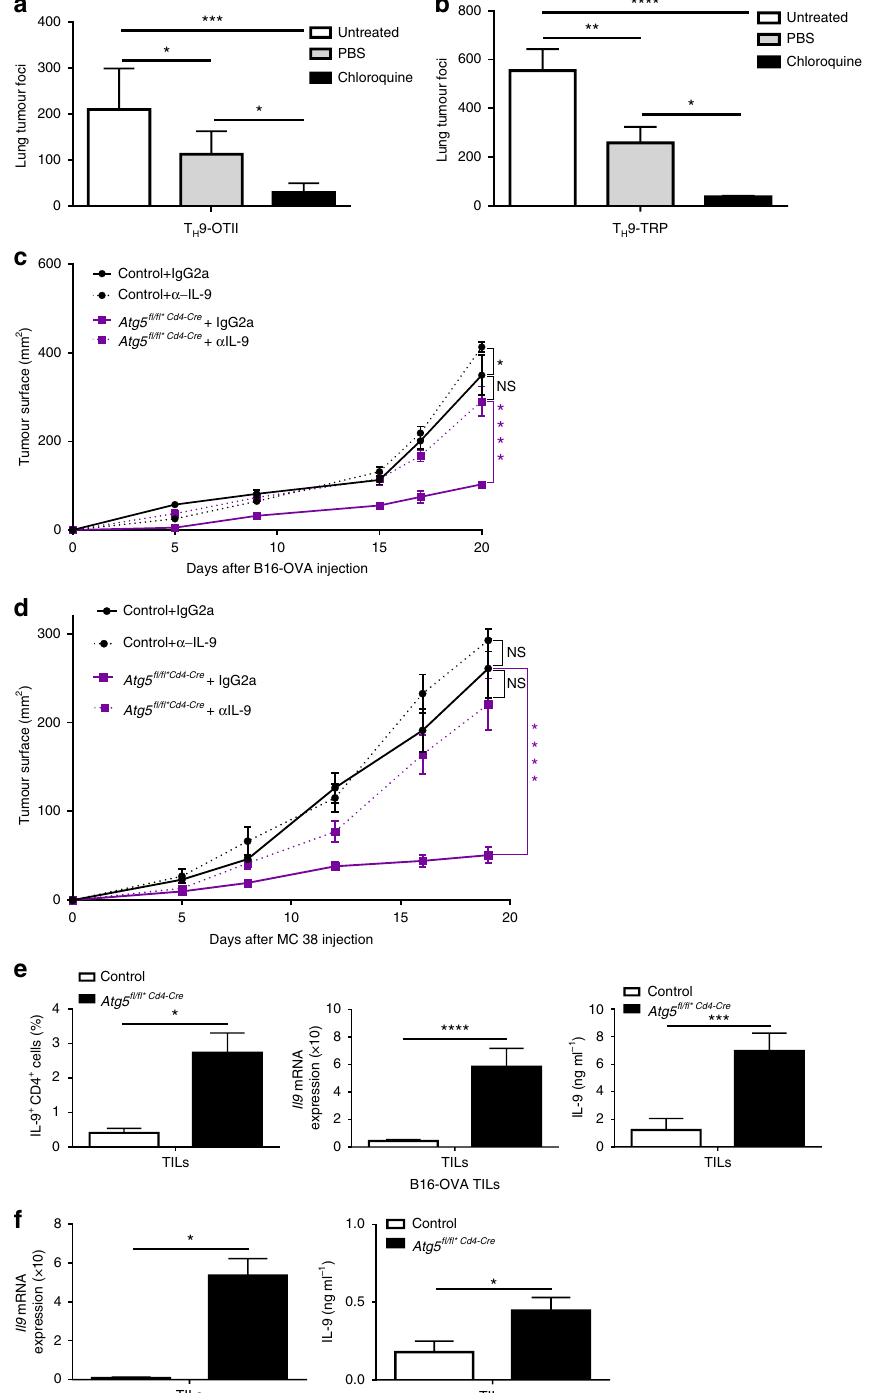
Fig. 6 Pharmacological and genetic blockade of autophagy in T H 9 cells enhance their IL-9-dependent antitumour functions in vivo. a WT mice were injected i.v. with 0.5×10 6 B16-OVA melanoma cells and effector 2×10 6 OT-II T H 9 cells differentiated with or without chloroquine, and mean numbers of lung tumour foci are depicted (mean+s.d., 5 mice per group, 3 independent experiments). b WT mice were injected i.v. with 0.5×10 6 B16 melanoma cells and effector 0.1×10 6 TRP T H 9 cells differentiated with or without chloroquine, and mean numbers of lung tumour foci are depicted (mean+s.d., 5 mice per group, 2 independent experiments). c , d Tumour growth (mean+s.e.m.) monitored three times a week, in B16-OVA or MC38 tumour-bearing control and Atg5 fl / fl *CD4-Cre mice that received control mouse IgG2a or anti-IL-9 neutralizing antibodies (10mg per kg body weight) at days − 1 and 0 and then twice a week for 20 days (mean+s.e.m.) e TILs of B16-OVA tumour-bearing control and Atg5 fl / fl *CD4-Cre mice isolated at day 20 after tumour cell injection and stimulated with ovalbumin peptides OVA 323 – 339 for 24h. IL-9 expression from OVA 323 – 339 CD4 stimulated TILs analysed by qPCR, ELISA and FACS. f MC38 TILs were stimulated with 50ngml − 1 of PMA and 1 μ gml − 1 of ionomycin for 24h. IL-9 mRNA expression was analysed by qPCR and ELISA (mean+s.d., 5 mice per group, 2 independent experiments). NS, not signi fi cant with P > 0.05; * P < 0.05; ** P < 0.01; *** P < 0.001; **** P < 0.0001. a , b One-way analysis of variance (ANOVA) test; c , d two-way ANOVA test; e , f unpaired Student ’ s t